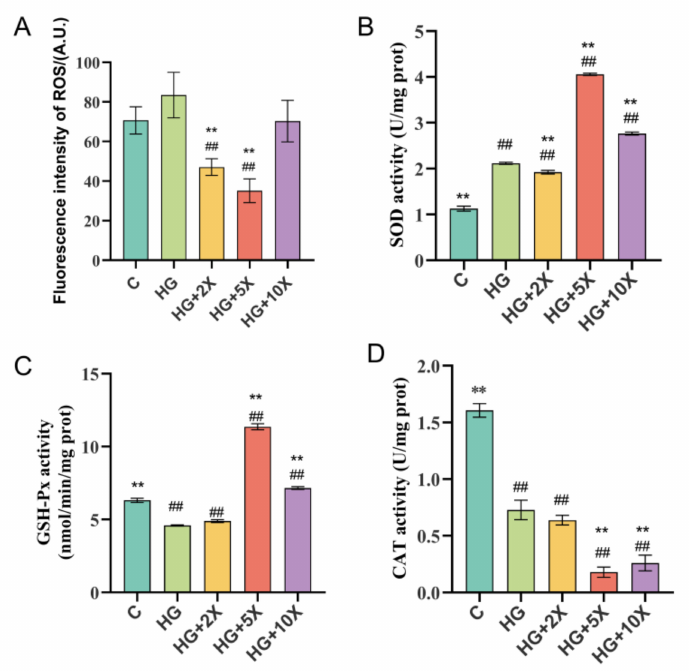
Figure 4. Effect of supplementation with A. muciniphila cell-free supernatant on antioxidant stress in C. elegans . ( A ) ROS fluorescent labeling test results; ( B ) SOD activity; ( C ) GSH-Px activity; ( D ) CAT activity. Results are expressed as mean ± SD deviation, and p -values are calculated by Tukey’s test. Compared with the control group, ## is significantly different at p < 0.01; compared with the high-glucose group, ** is significantly different at p <